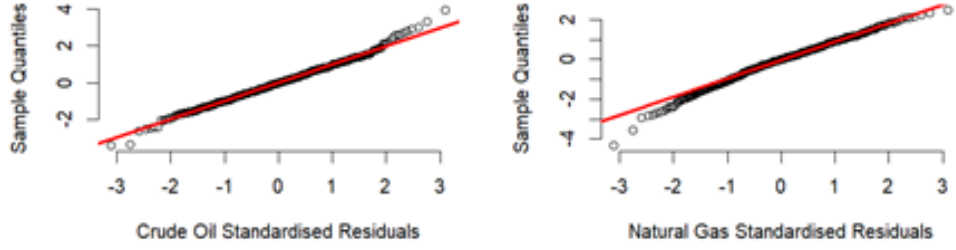
Figure 5. Q-Q plots for the standardized